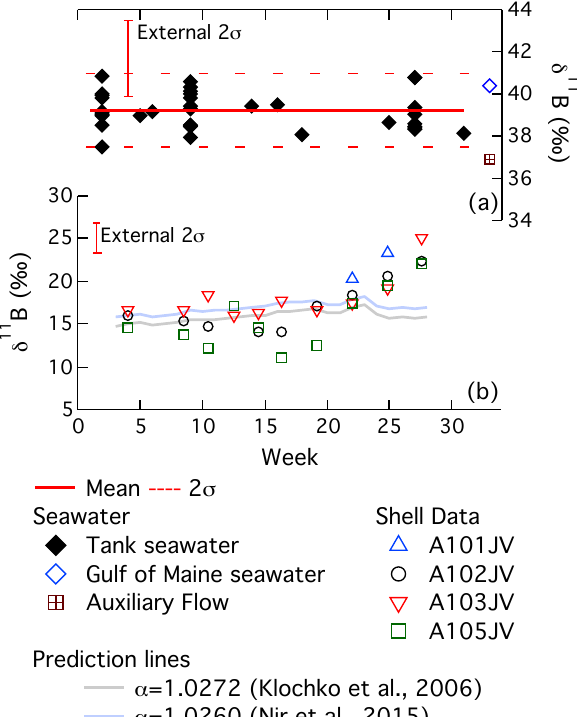
Figure 6. GoM boron data for (a) seawater samples and (b) shell samples. Two prediction lines listed were calculated based on our instrumental culture seawater pH, temperature, and salinity data, and two boron fractionation factors: α = 1.0272 (Klochko et al., 2006) and α = 1.0260 (Nir et al., 2015), where α ≡ Equation (4) was used for the